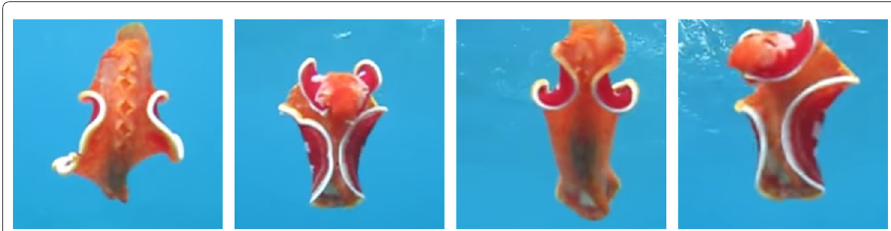
Fig. 2 A free swimming sea slug HexabranchusSanguineus . The frames are 2s apart. Images used with permission from the copyright holders of the original video (Jones